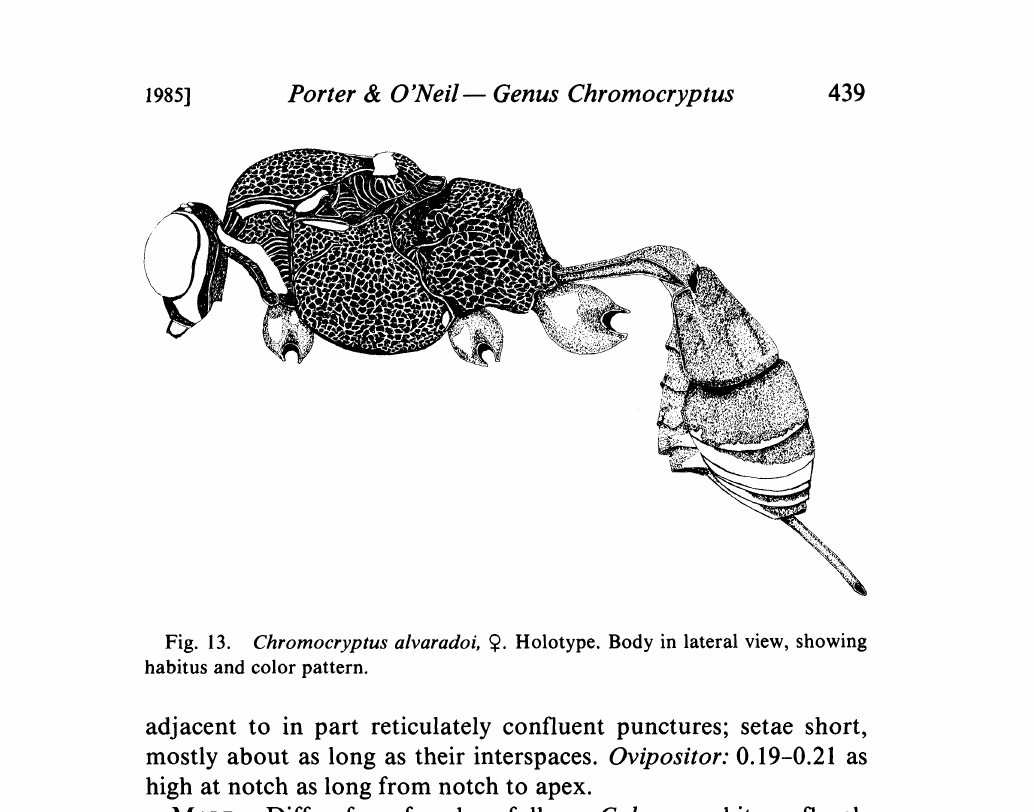
Fig. 13. Chromocryptus alvaradoL habitus and color